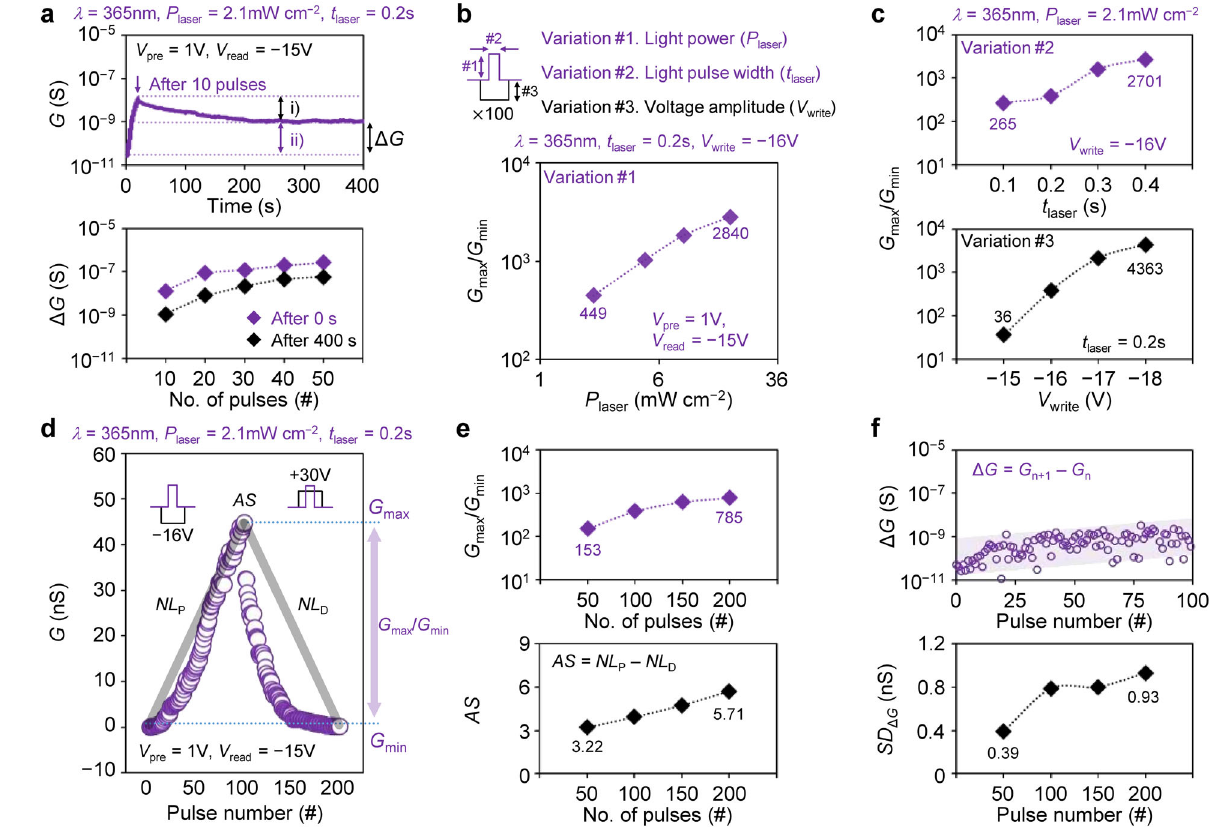
Fig. 3 Dynamic characteristics of vdW photoelectroactive synapse. a Conductance ( G ) response decaying characteristic (upper panel) and retained conductance difference ( Δ G ) immediately after application of the co-stimuli and after 400 s (lower panel). b Dynamic range of conductance ( G max / G min ) with respect to light power. c Extracted dynamic range with respect to the variation of light pulse width and voltage amplitude. d Long-term potentiation/depression (LTP/D) characteristics of the photoelectroactive synaptic device. e Dynamic range (upper) and asymmetricity (lower) vs. the number of pulses for the LTP/D curves. f Conductance difference between n-th and (n + 1)-th states ( Δ G ) vs. pulse number (upper) and standard deviation (SD) of Δ G vs. pulse number